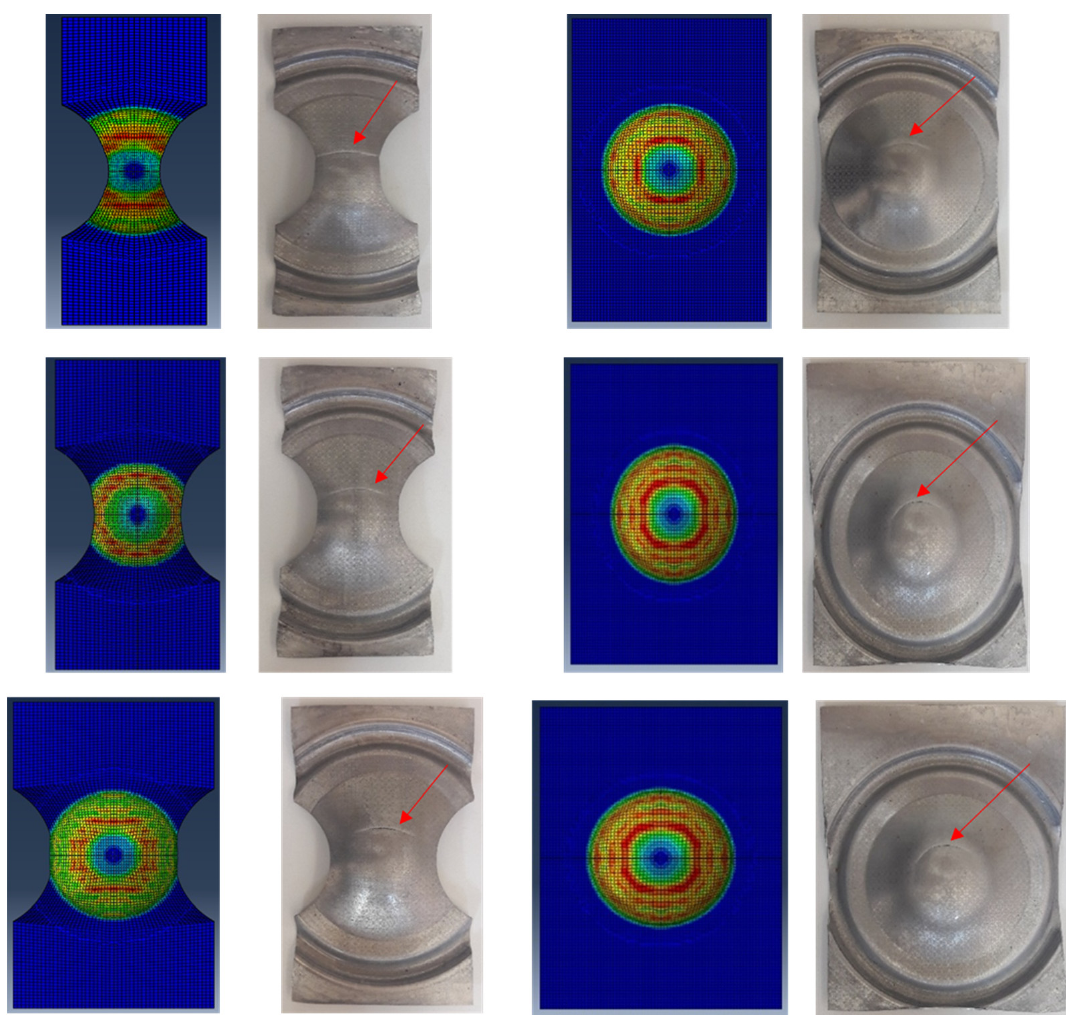
Figure 7. Necking position of the experimental sample and PEEQ result of simulated tests.